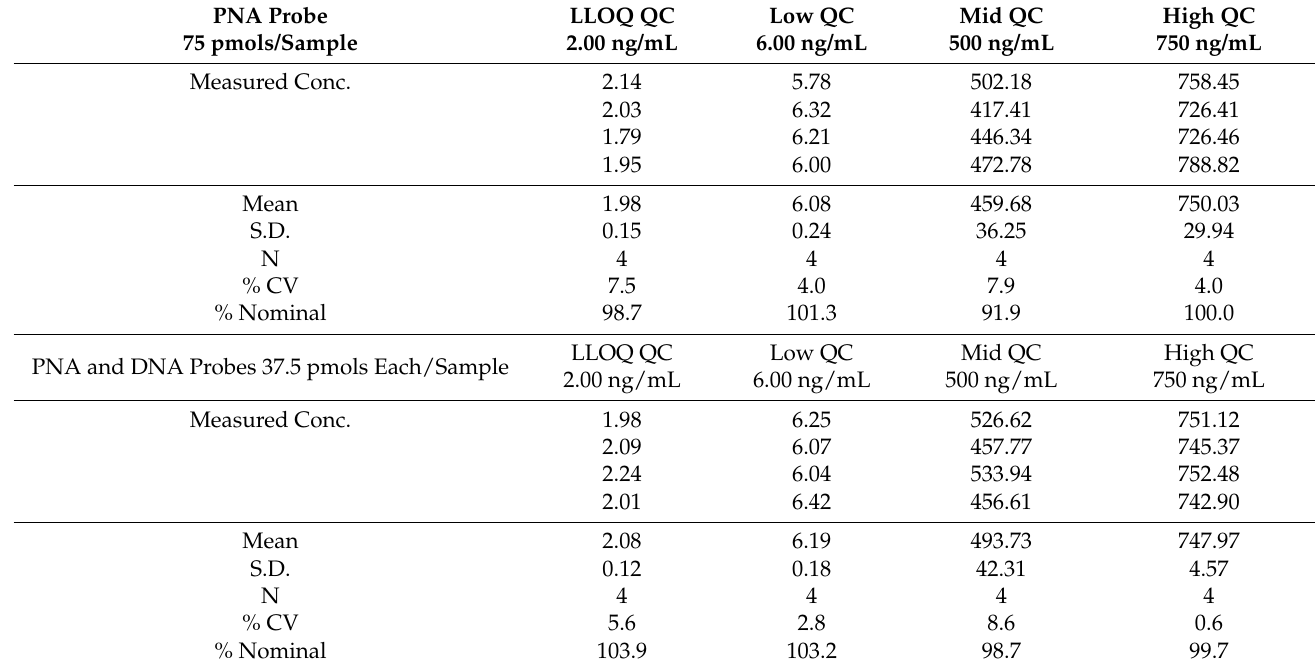
Table 1. Comparison of different capture probes for the analysis of siRNA-01 QCs in monkey plasma. PNA Probe LLOQ QC 75 pmols/Sample 2.00 ng/mL Measured